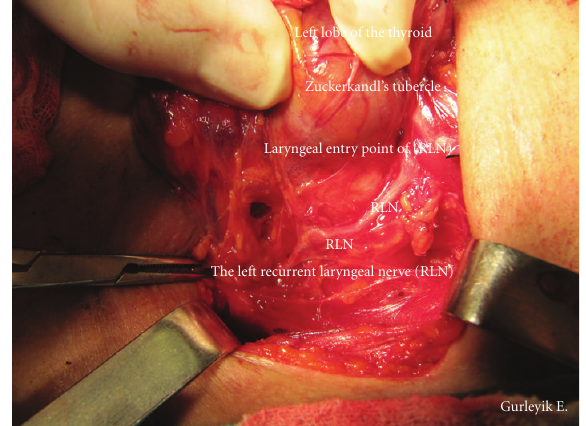
Figure 3: After freeing the tubercle of Zuckerkandl and Berry ligament, the RLN returned back to its usual position in trachea- esophageal